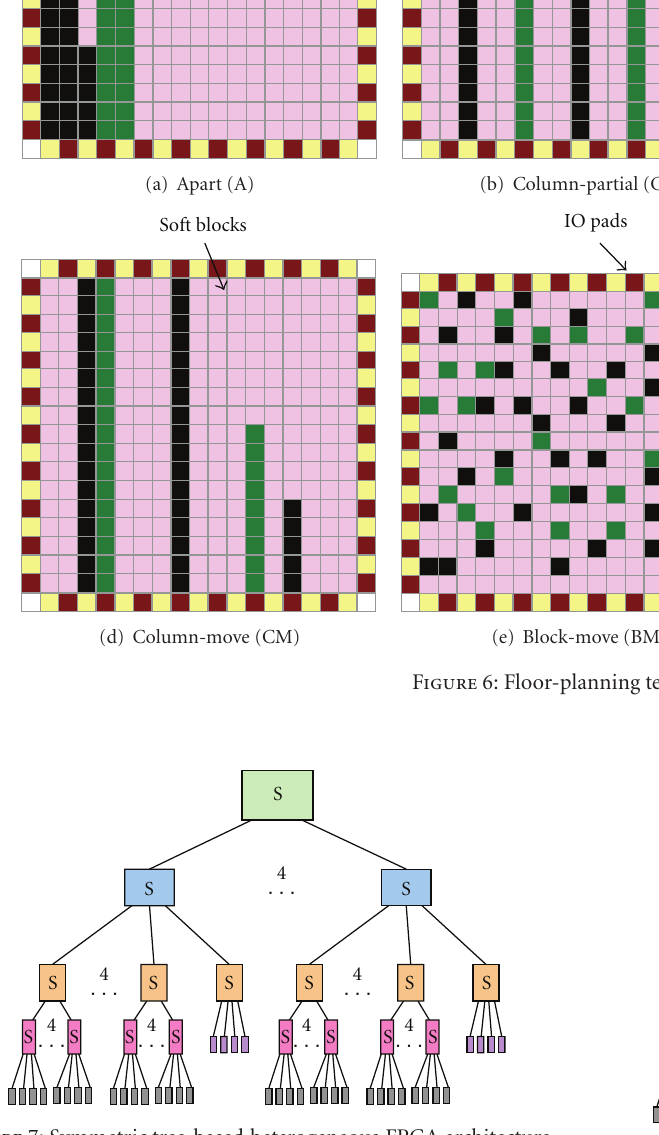
Figure 8: Asymmetric tree-based heterogeneous FPGA architec- ture. (a) substructure containing only CLBs. (b) substructure containing only